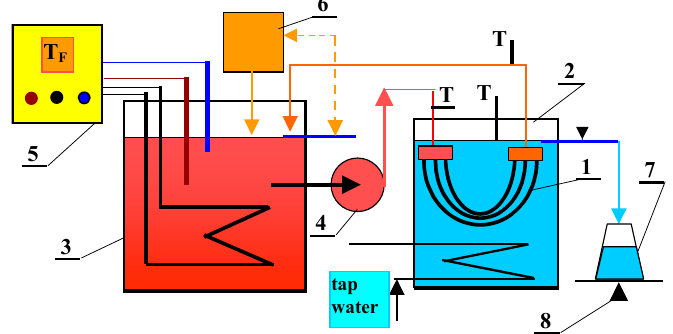
Figure 4. MD process experimental set–up. 1 –submerged MD module, 2—distillate tank with cooling,